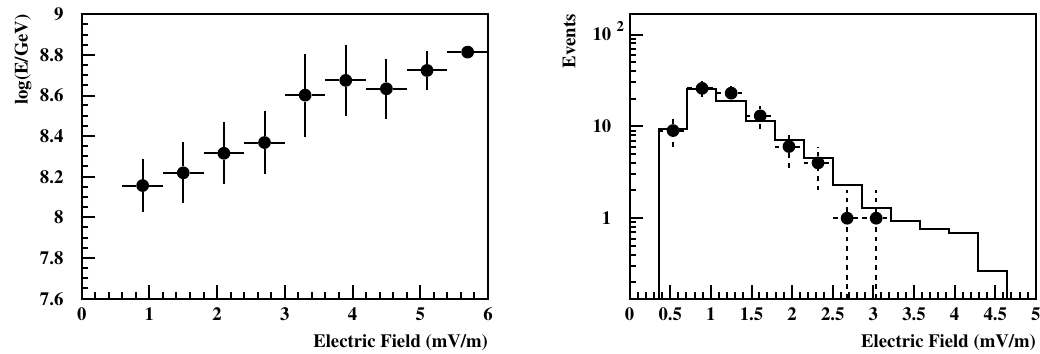
Figure 7. ( Left ) the energy of the primary as a function of the induced electric field at the antenna positions as derived from the simulation for double station coinicedence events. ( Right ) the electric field distribution of the data sample (points) in comparison with the simulation